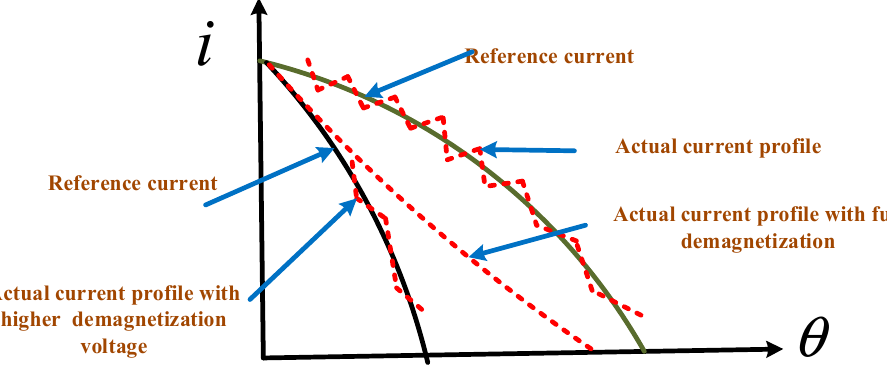
Figure 7. Three possibilities of current control at the commutation.